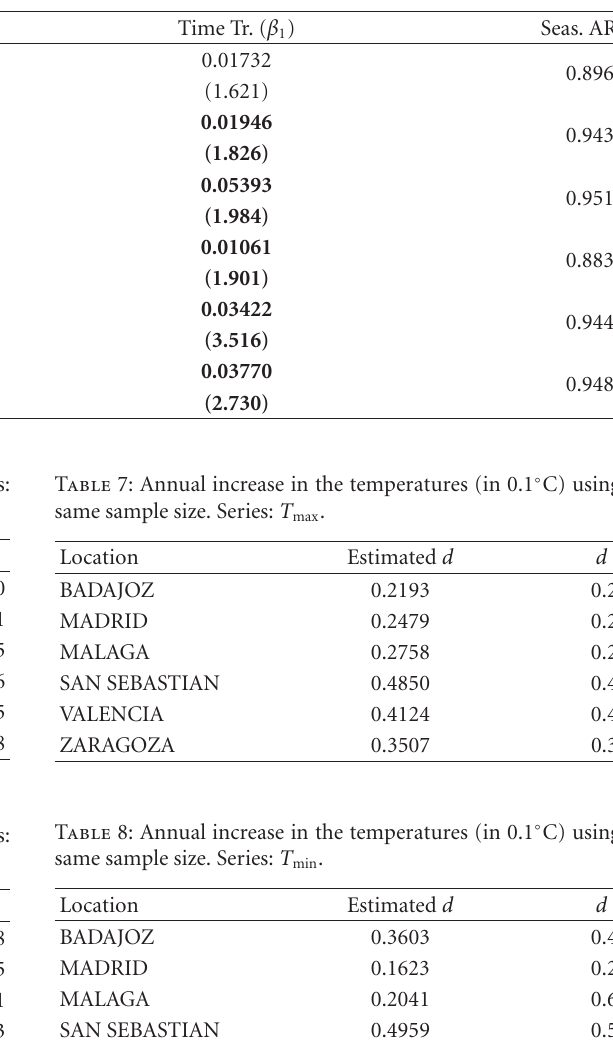
Table 4: Estimates of the time trend coe ffi cients and the seasonal AR(1) coe ffi cients assuming that the process is I (0), i.e., d = 0. Series: t -values in parenthesis. In bold, significant time trend coe ffi cients.) T min .